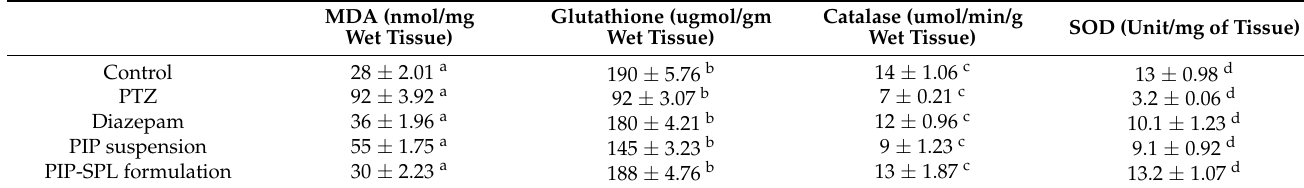
Table 7. Effect of different treatments on oxidative stress markers of the brain.